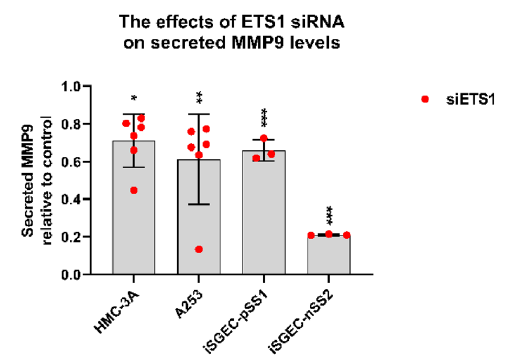
Figure 2. Effects ofETS1 siRNA-mediated knockdown on MMP9 protein expression in salivary gland derived cell lines. Semi-quantitative(densitometric) Western blotanalysis( A/B )and representative Western blots( C/D ) of siRNA knockdown experimentsareshown. ETS1andMMP9 protein levels were determined 72hrspost-transfection with siRNA targetingETS1 (siETS1), relative to non-targetingsiRNA (siNT) (control)in HMC-3A( A/C )and A253( B/D )whole cell lysates. MMP9 protein levels were reduced in bothA253 and HMC-3A cells when transfected with 3 A cells when transfected with siETS1. Equal protein amounts were loaded into each lane and respective target normalized to cofilin protein expression. Western blot sections corresponding to either (ETS1 and Cofilin) or (MMP9 and Cofilin) were acquired from the same gel/blot, percell line, and processed identically from the same replicate sample, if possible. Loading controls and target proteins of the same gel/blotare imaged separately for optimized exposure requirements among the loading control vs . target protein (s). The effectsofETS1(siETS1) siRNA knockdown onMMP9 protein secretion into culture media were also determined ( E ).Total MMP9 (active and inactive) was measured by ELISA and presented as fold-decrease of the non-targeting siRNA (siNT) control. InSGCLs HMC-3A (n = 6) and A253 (n = 6), there were significant reductions in total MMP9 protein supernatant levels after siRNA knockdown of ETS1( E ). Total MMP9 in the cell culture supernatant of iSGEC-pSS1 (n = 3) and iSGEC-nSS2 (n = 3) was significantly reduced by ETS1 knockdown ( E ). Mann–Whitney U-test was used to determine significant differences among the control (siNT) and siETS1. Results are presented as mean +/− standard deviation (SD). (***p < 0.001), (**p < 0.01), (*p <